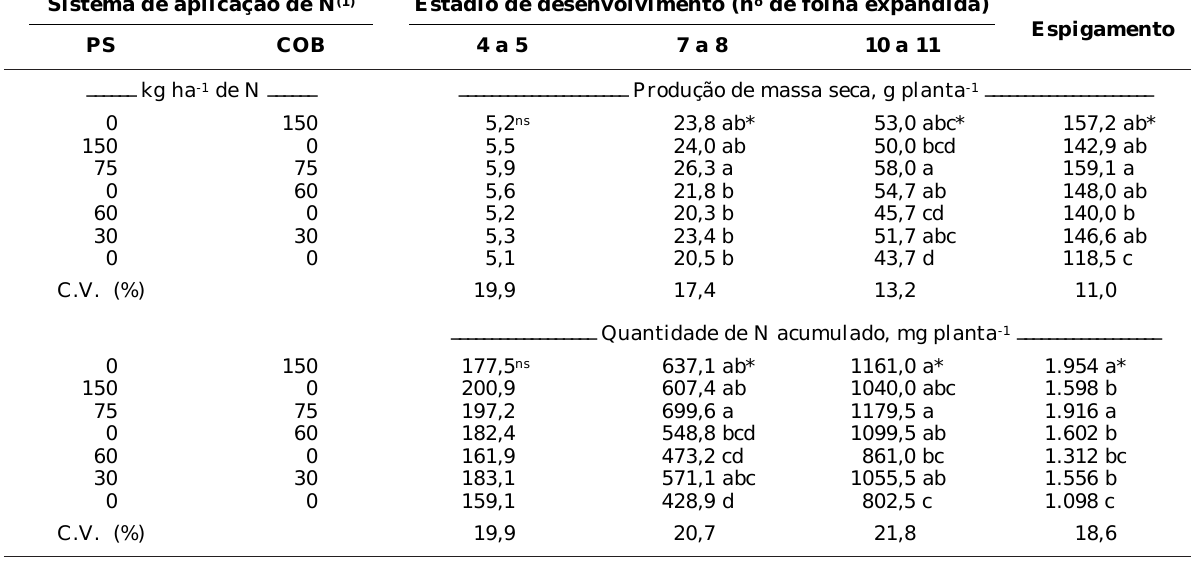
(1) Quantidade de N aplicada em: PS = pré-semeadura do milho (momento da dessecação da aveia preta), COB = cobertura (dividida em duas aplicações, em doses iguais, nos estádios de quatro a cinco e sete a oito folhas expandidas). Em todos os sistemas, foram aplicados 30 kg ha -1 de N na semeadura juntamente com a adubação de P na coluna, não diferem entre si pelo teste de Duncan (P £ 0,05). ns Não-significativo (P £ 0,05).